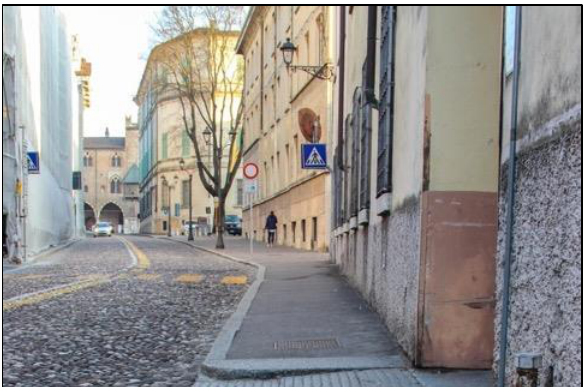
Figure 6. Example of linear physical barrier: sidewalk with excessive transversal, connecting Virgilian Square to Sordello Square, is a source of fatigue and danger for someone with physical impairments © Sebastiano Marconcini, 2017